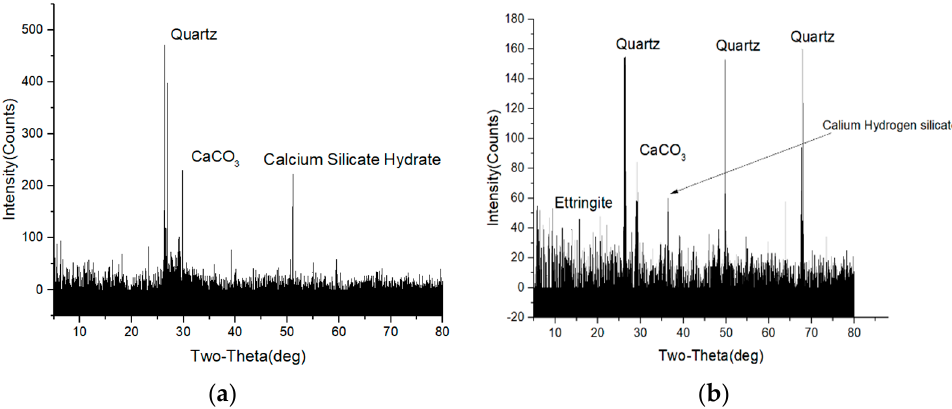
Figure 5. Powder diffraction patterns from concrete. ( a ) Nano-TiO 2 modified concrete at room temperature. ( b ) Nano-TiO 2 modified concrete after dry-wet cycle.